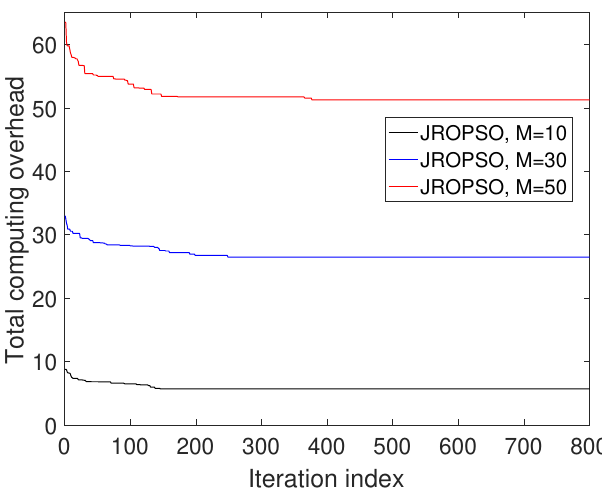
Figure 2. JROPSO convergence in terms of total computing overhead according to the number of iterations.